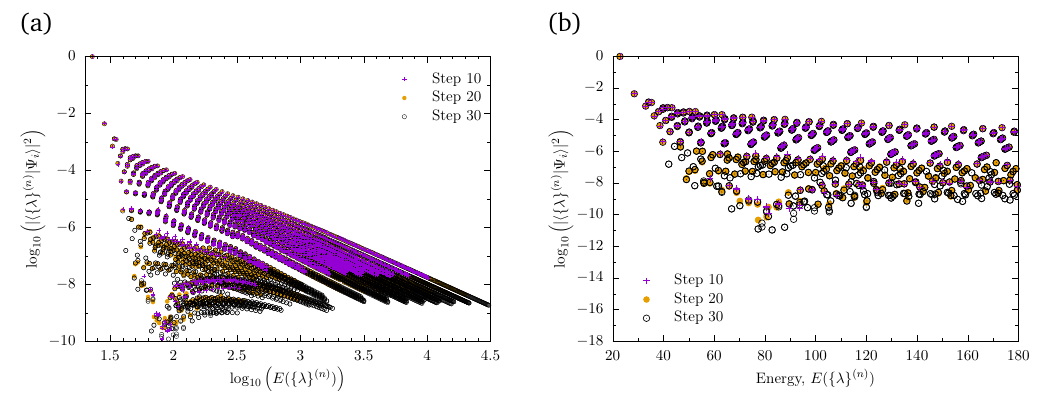
Figure 9: (a) The convergence of the overlaps at different steps of the numerical renormalization group procedure implemented within the high overlap states trun- = 20 ground state constructed is constructed in terms of cation scheme. The c i = 10 eigenstates. Parameters of the procedure are as in Fig. 8. (b) A focused c f region of the plot, to be compared directly with Fig.